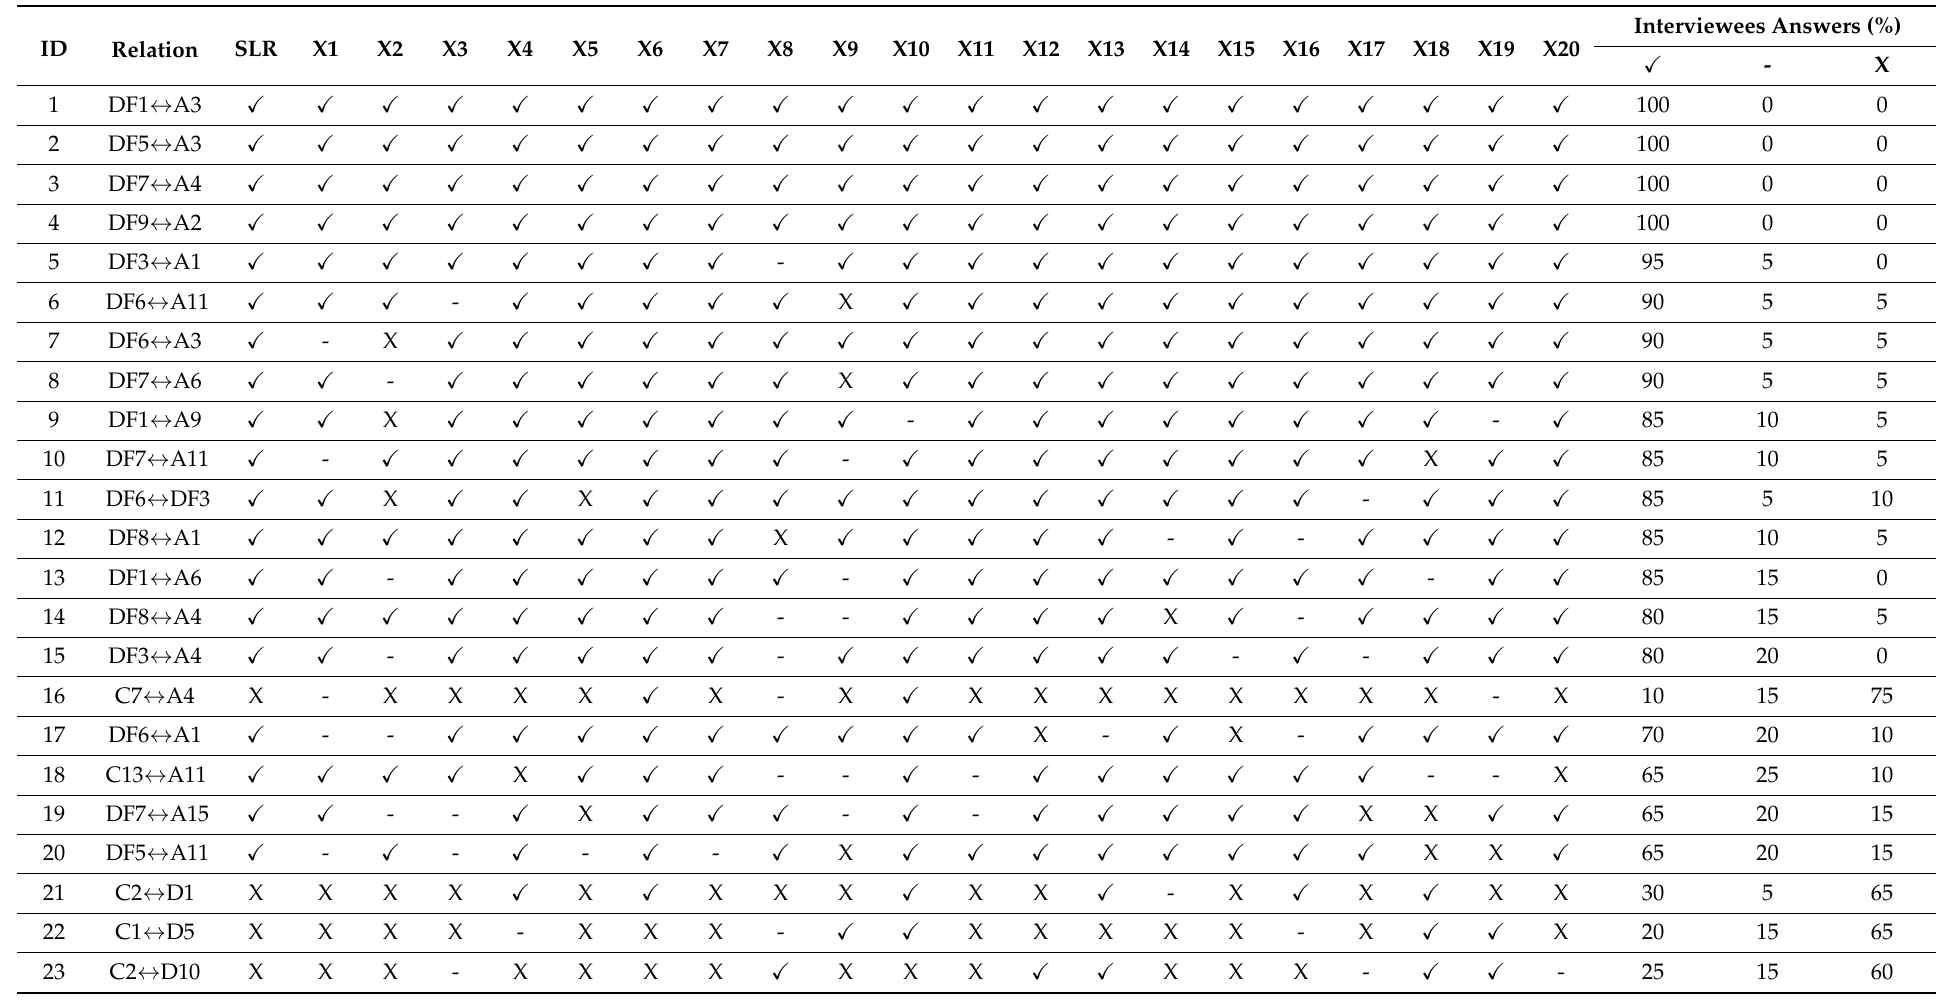
Table 9. RW decision factors relation validation based on interviewees’